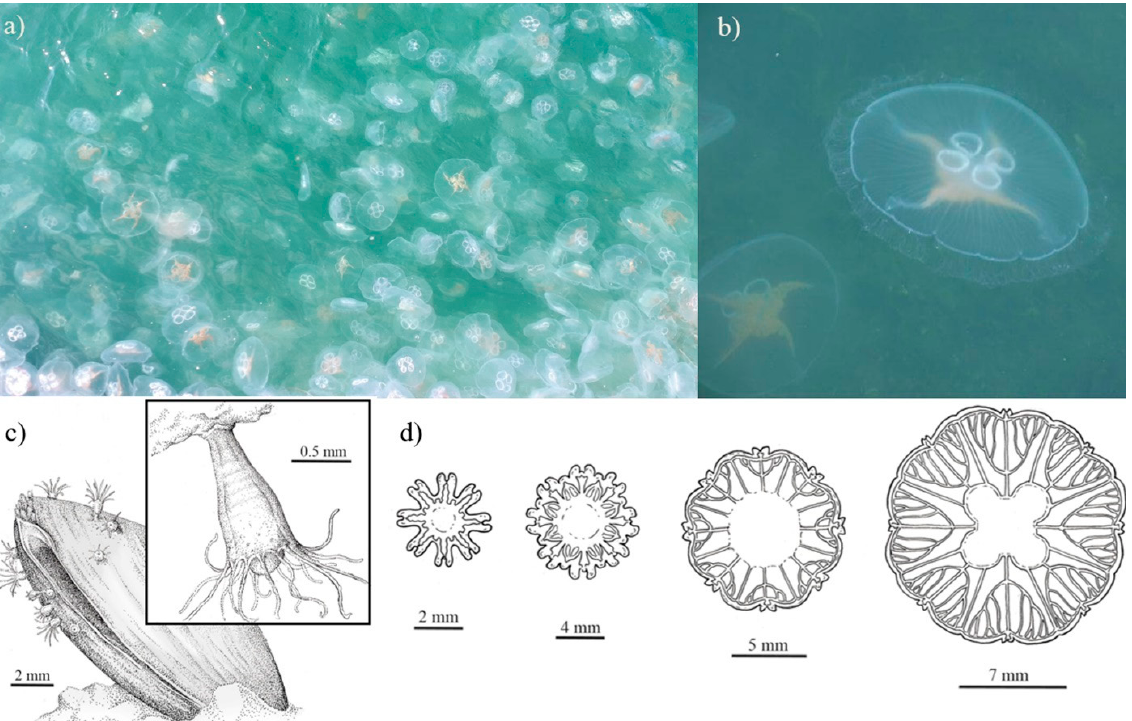
Figure 2. The moon jelly Aurelia aurita ( a ) in a high abundance patch in Eckernförde, SW Baltic Sea, June 2020, ( b ) a sexually mature female in Kiel Bight, August 2014, ( c ) polyp colony with close up of an individual polyp (inlet) and ( d ) development sequence of ephyra. Image credit ( a , b ): C. Jaspers, ( c , d ): N. Bezio.